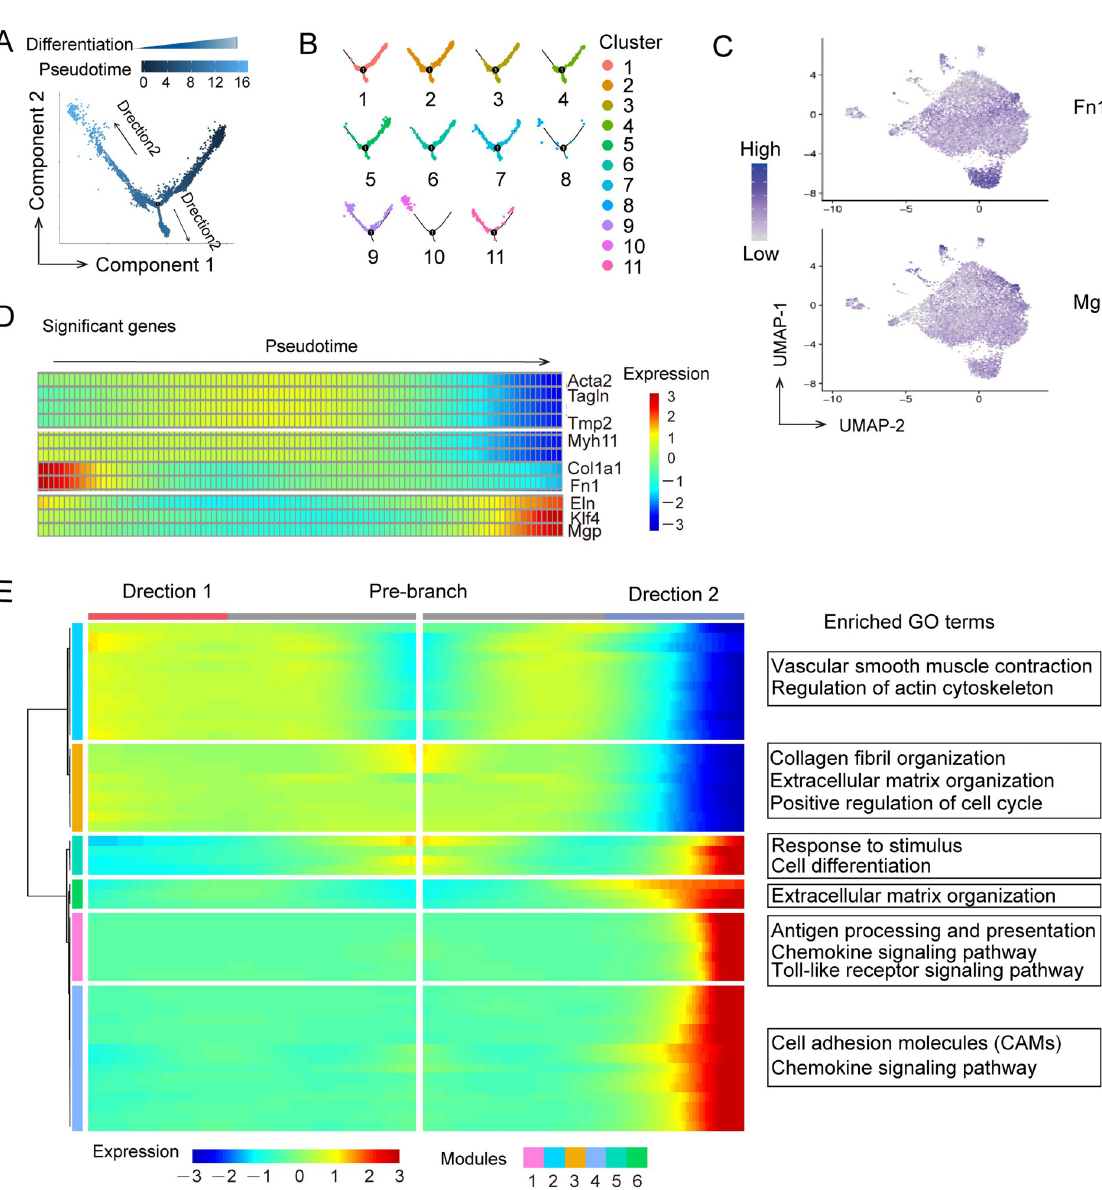
Fig 2. Pseudotime analysis of the medial VSMC subpopulations. (A) Pseudotime trajectory of Myh11 -expression cells. (B) Cells ordering from different cluster along the pseudotime trajectory. (C) Relative expression of Fn1 and Mgp in Myh11 -expression cells. Cells were projected onto a UMAP plot. (D) Heat map of the selected significantly changed genes along the pseudotime trajectory. (E) Branched heat map of the relative expression of 50 genes along the inferred pseudo time axis (cataloged hierarchically into six gene modules) corresponding to Direction 1 and Direction 2, and representative GO terms enriched in each gene